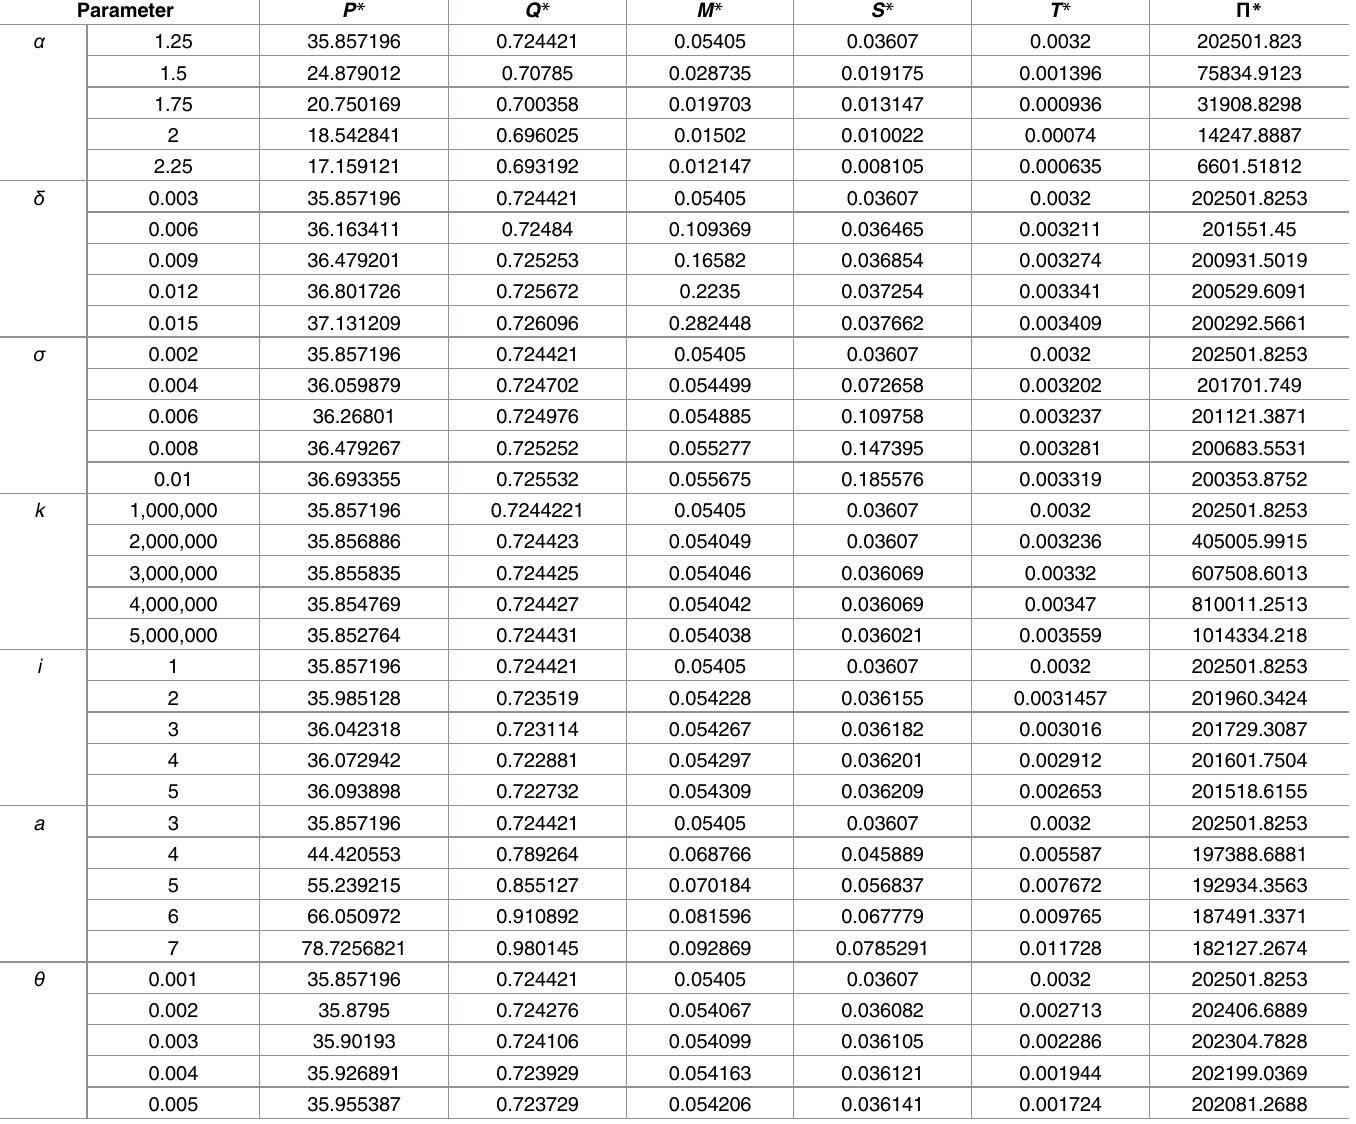
Table 1. Sensitivity analysis on